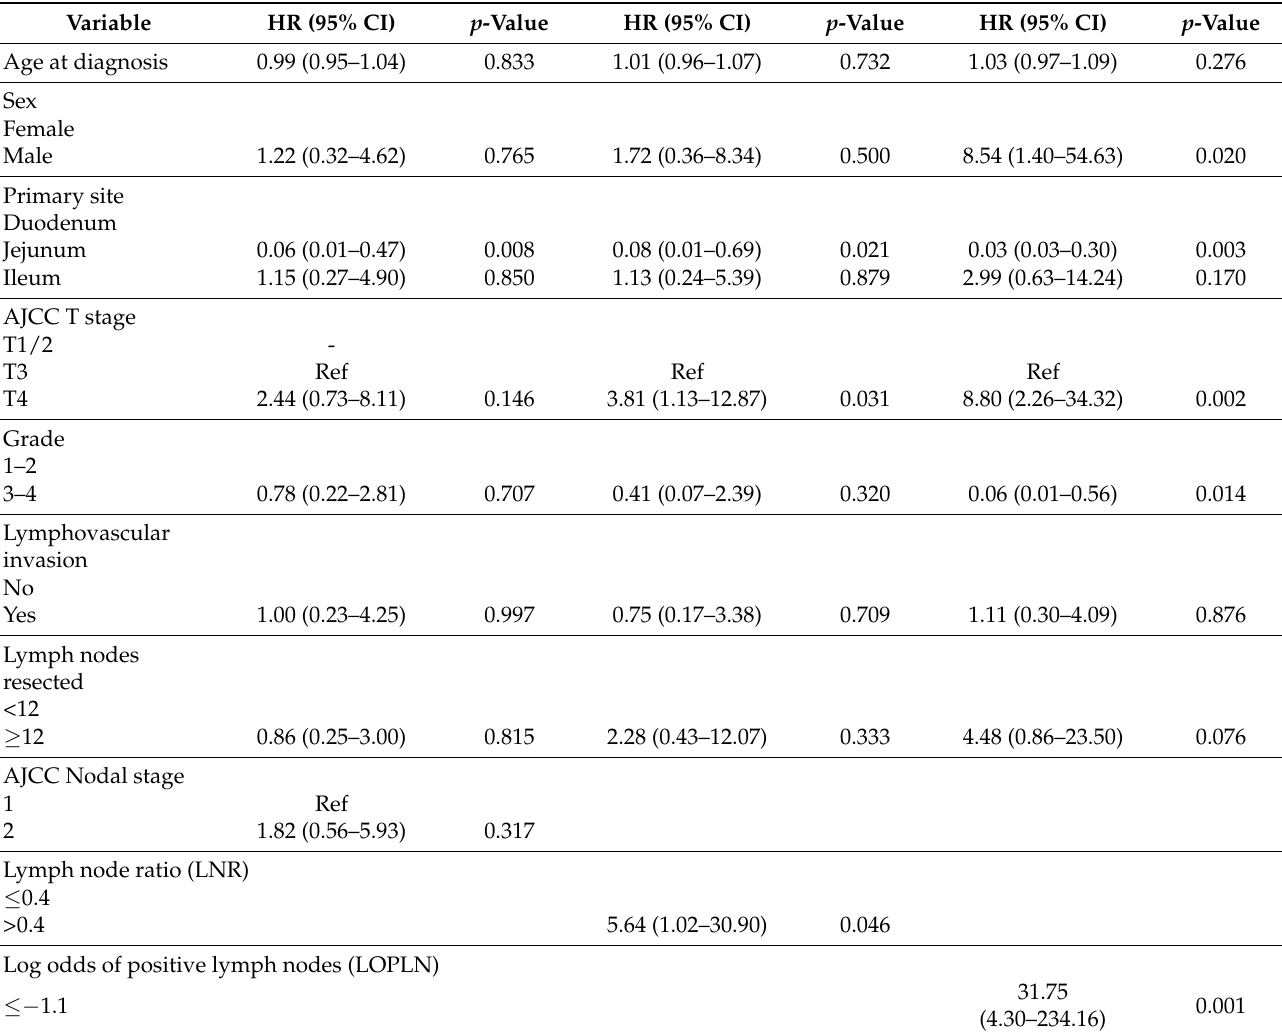
Figure 2. Kaplan – Meier curves showing overall survival of patients who underwent resection of primary small bowel adenocarcinoma with at least one lymph node affected by tumour (n = 71) by ( A ) AJCC nodal stage ( B ) LNR, and ( C ) LOPLN. Table 4. Factors associated with overall survival in node-positive patients (n = 71).